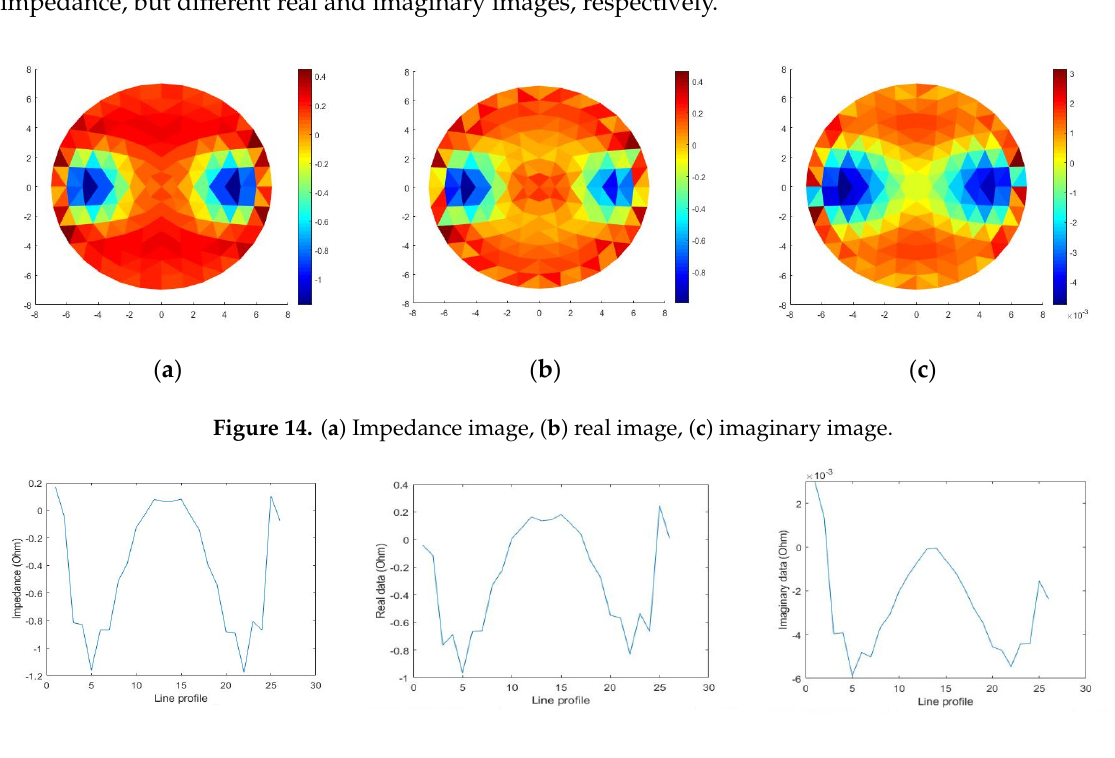
Figure 13. The triangular element model used in this study. Table 2. Data of the electrical properties many tissue from Gabriel.